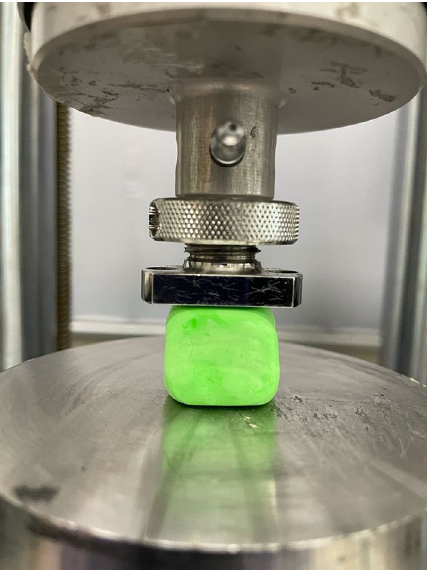
Figure 5. A slime specimen (sample C) ready for mechanical compressive tests.